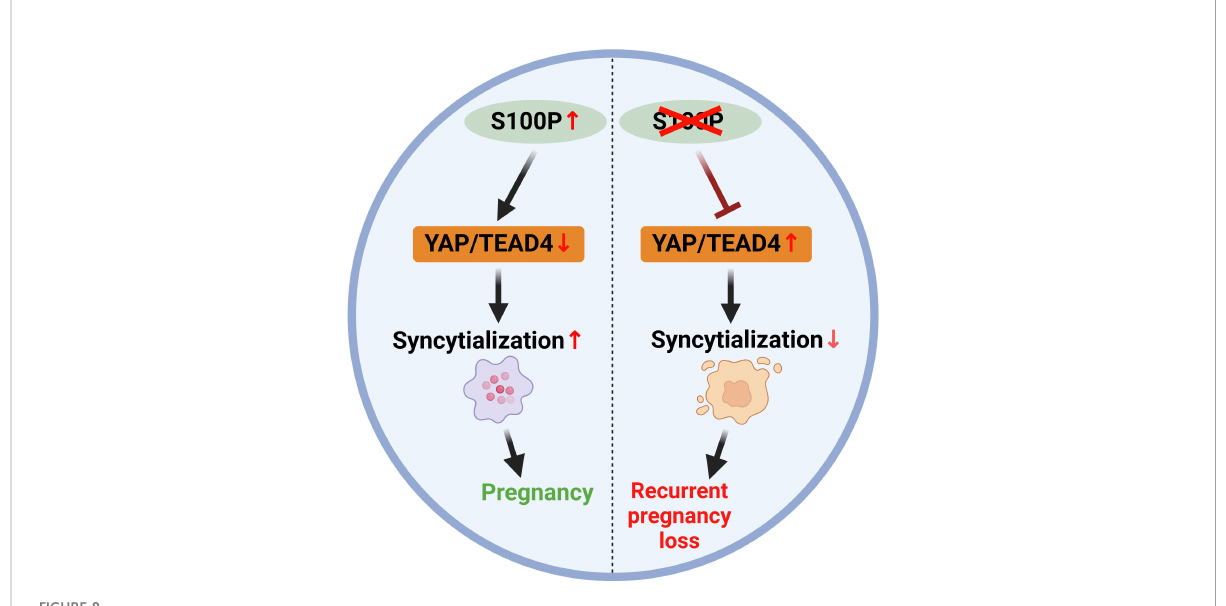
FIGURE 8 Schematic model illustrating that S100P participates in trophoblast syncytialization during early placenta development by downregulating YAP1 and